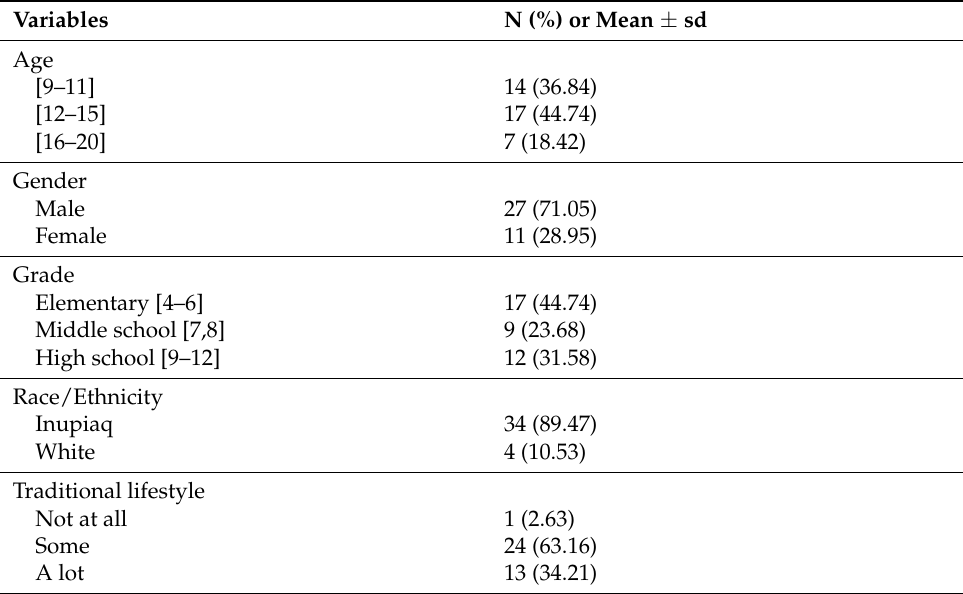
Table 1. Demographic and anthropometric statistics (n =